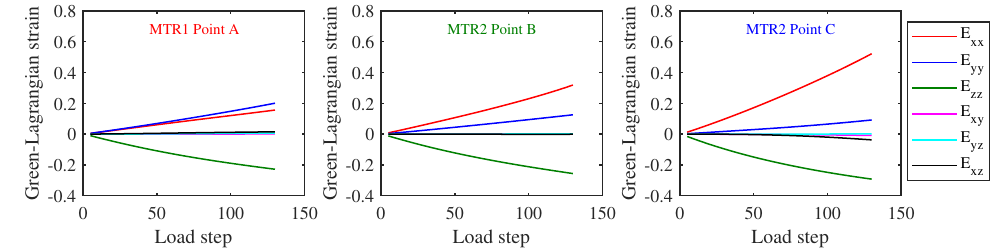
Figure 4. Green–Lagrange strain history of selected mesoscale MTR points in the normal direction (ND) compression simulation. Point positions are extracted from Figure